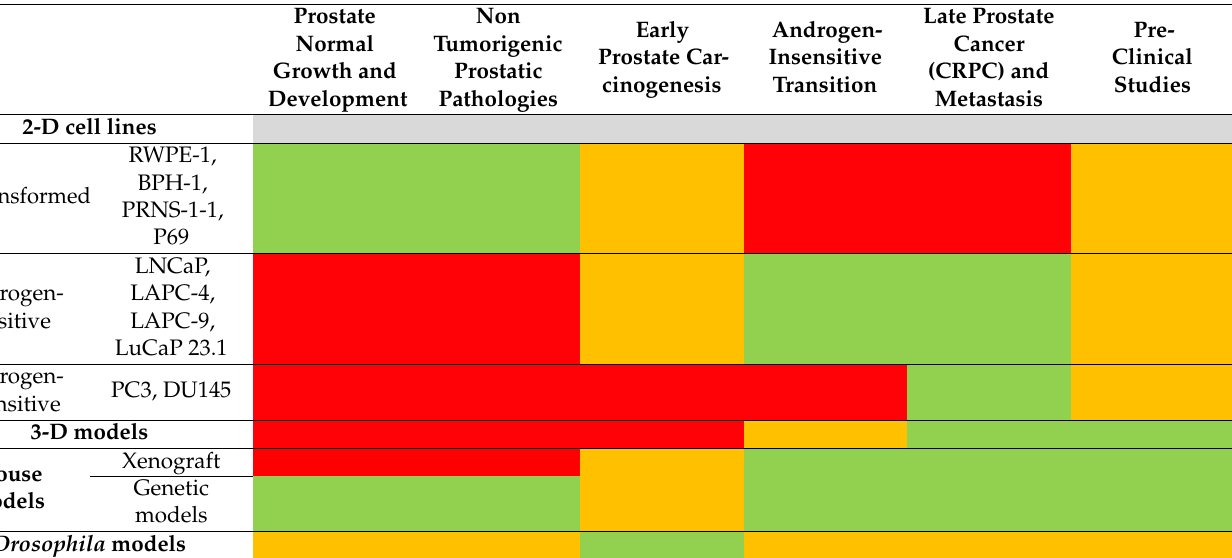
Table 1. Use of different prostate cancer